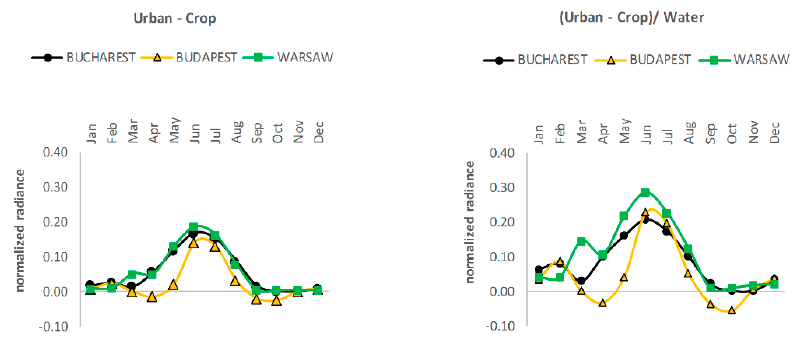
Figure 3. Differences between land cover classes: urban and cropland of multiannual monthly mean values of MIR radiance for all cities ( left ) and these differences normalized by MIR radiance from open water class ( right ).